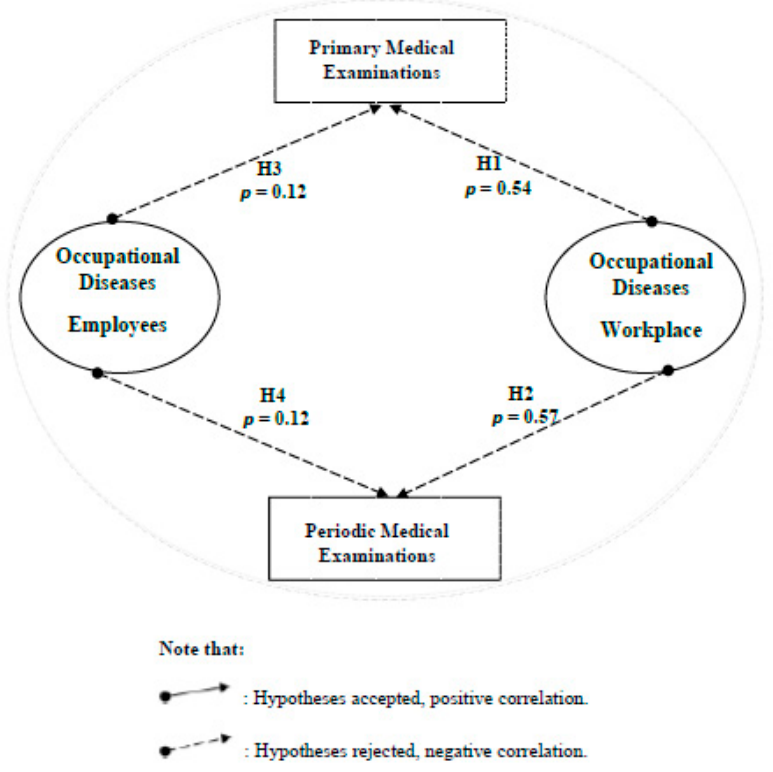
Figure 23. The presentation of case correlation (4) and its hypothesis testing.